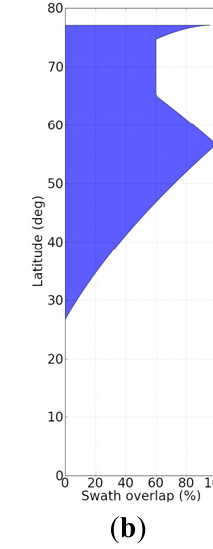
Figure 20. Geometry of sub-cycle overlaps. ( a ) describes their geometry as a function of latitude and ( b ) shows the percentage of the reference swath (grey in (a)) that is also being measured by adjoining swaths (green and blue in